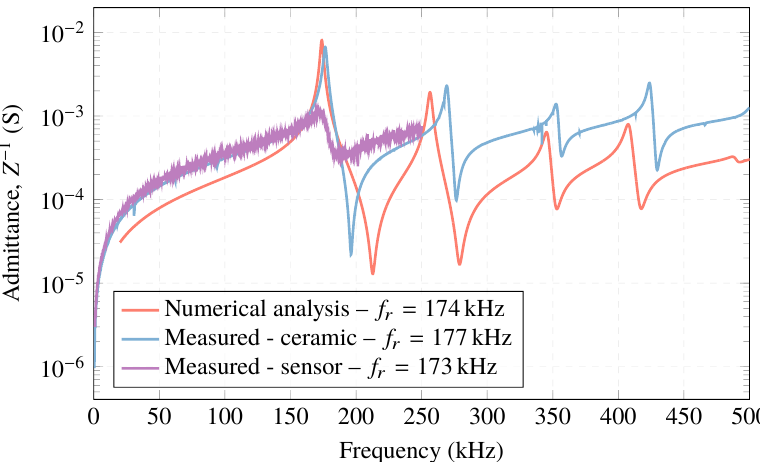
Figure 12. Simulated and measured electrical admittance obtained for the ceramic and sensor in water.